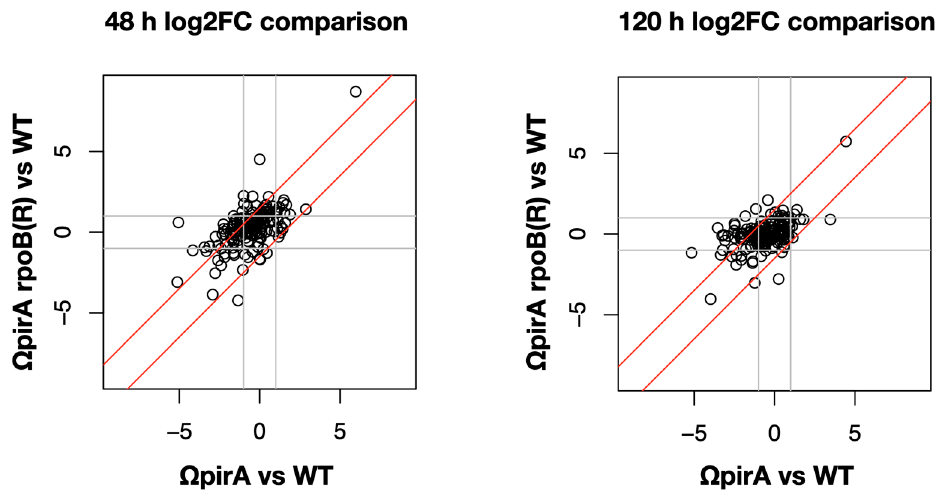
Figure 7. Differential expression of sRNas and asRNAs of class I in S. ambofaciens ATCC 23877 (w.t.), and derivative Ω pirA and Ω pirA rpoB(R) mutants at 48 h (left panel) and 120 h (right panel). (Supplementary Table S13). Log2fold changes of the two mutants compared to the w.t. strain were reported in the plots as indicated by the labels.